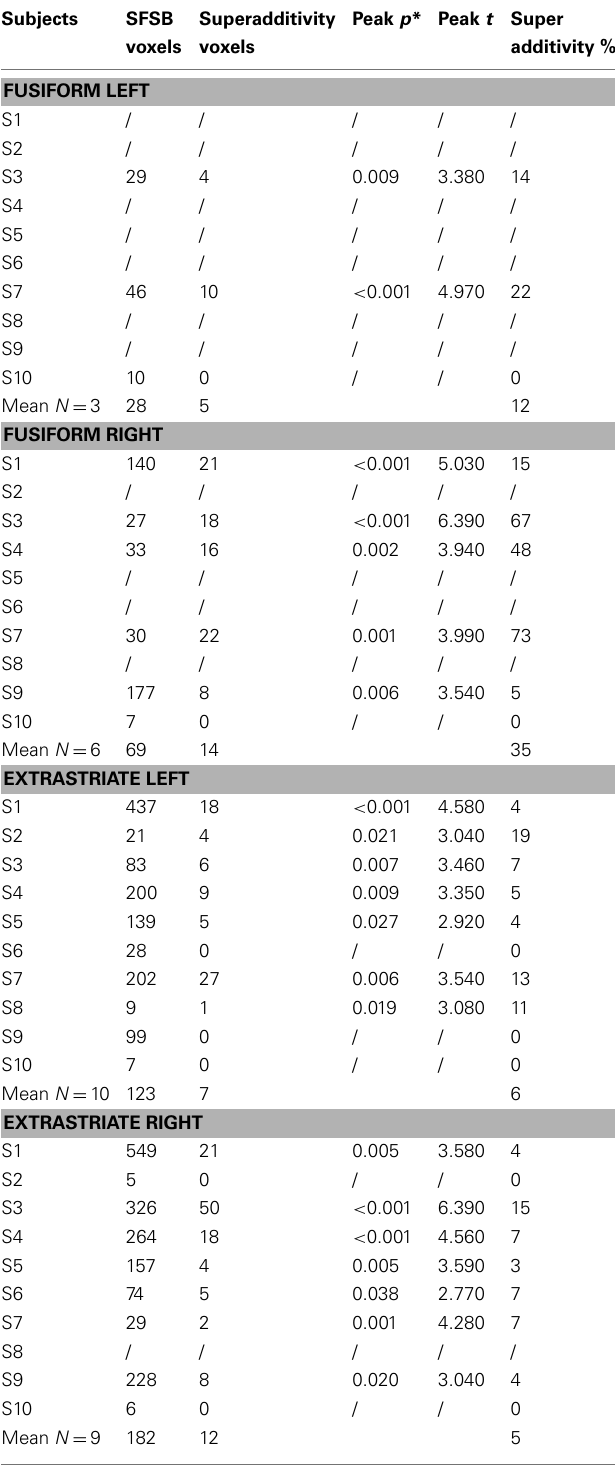
Table 2 | Superadditivity effects: Individual data.